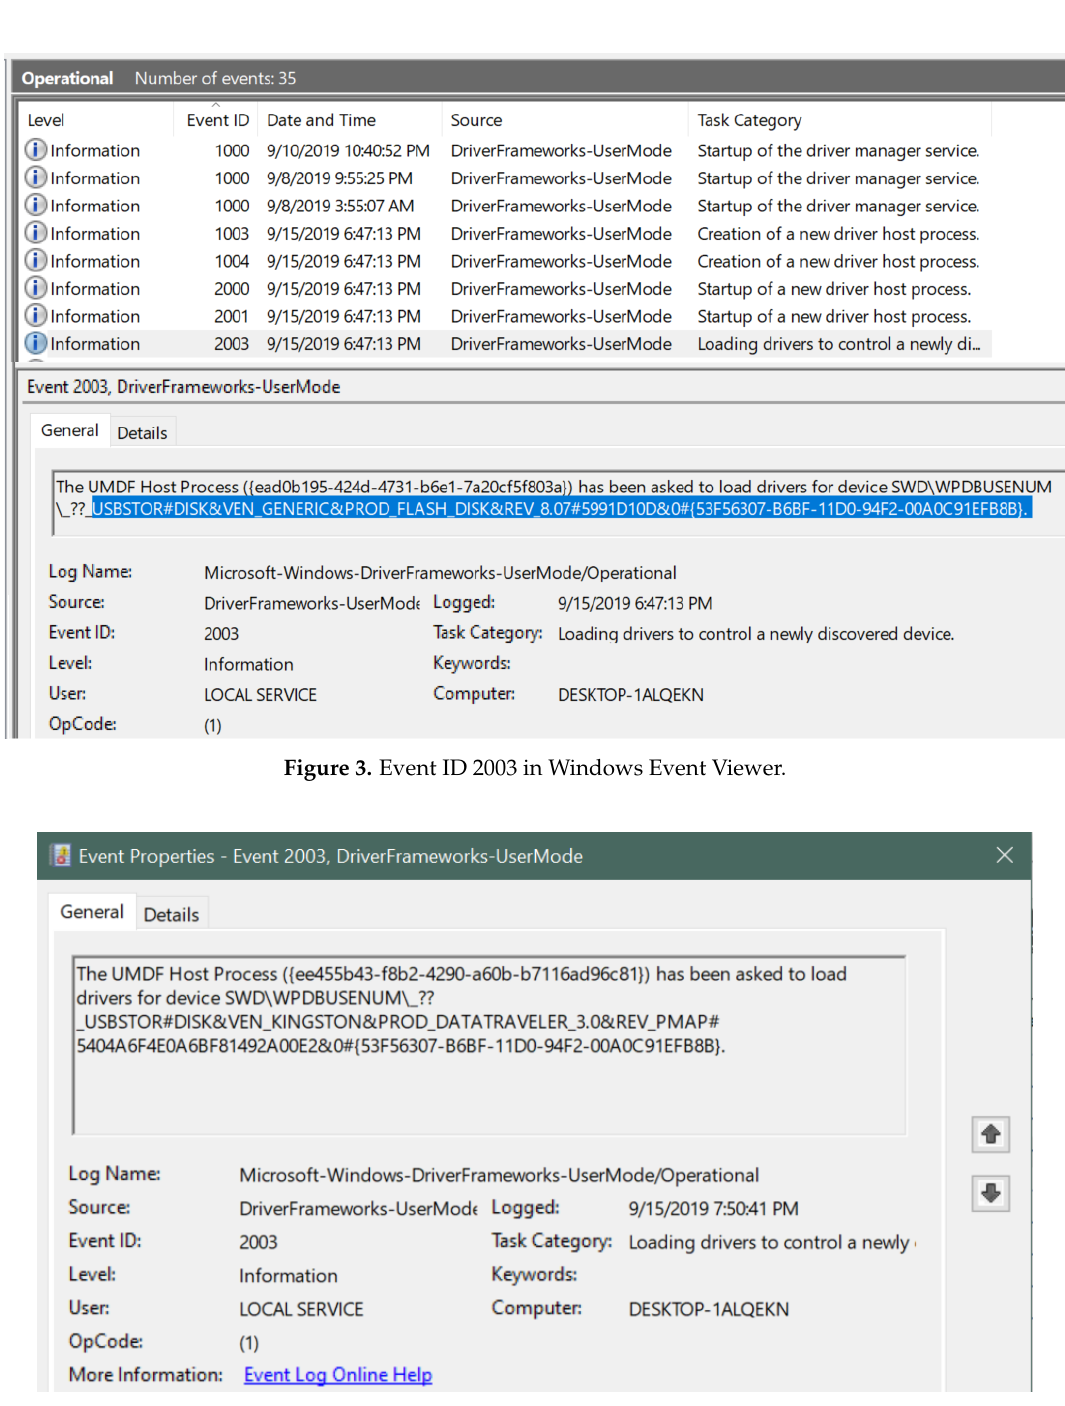
Figure 4. Event ID 2003 for Kingston USB